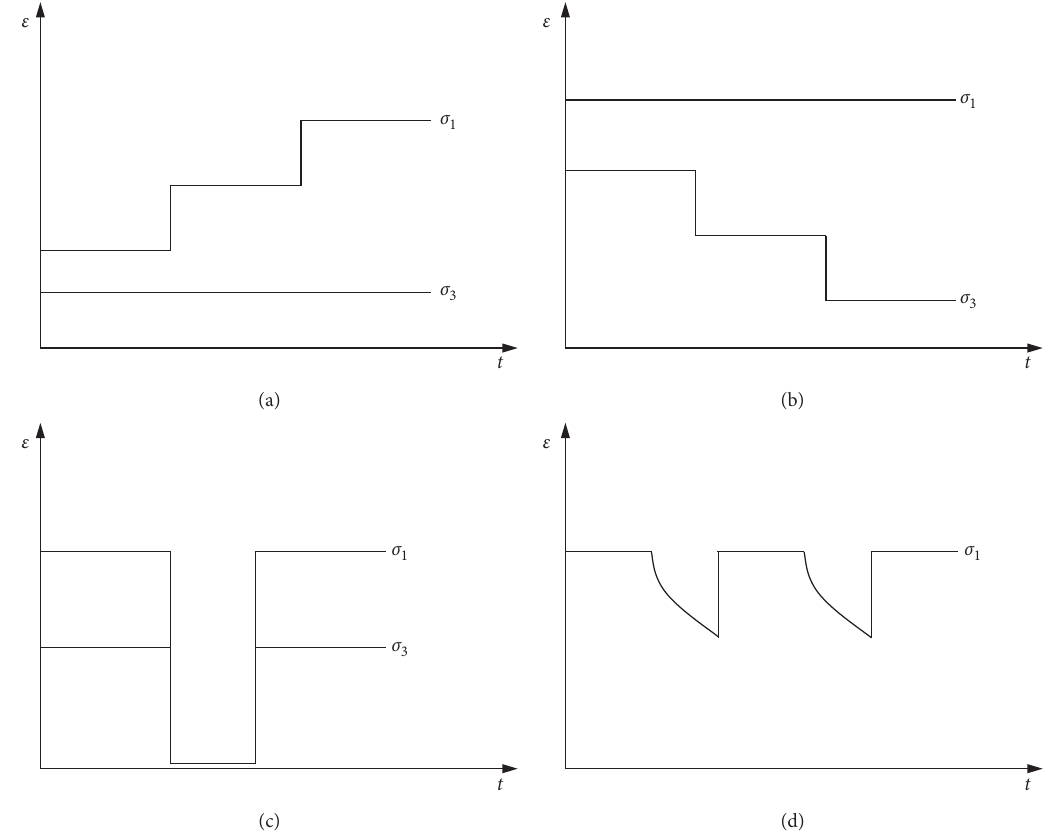
Figure 1: Schematic diagram of loading path: (a) the creep test carried out under multistage loading axial stress (confining pressure was fixed); (b) the creep test carried out under multistage unloading confining pressure (axial stress was fixed); (c) unloaded axial stress and confining pressure to 0 and lasted for a period and then recovered them to the initial state; (d) creep and stress relaxation tests performed alternately